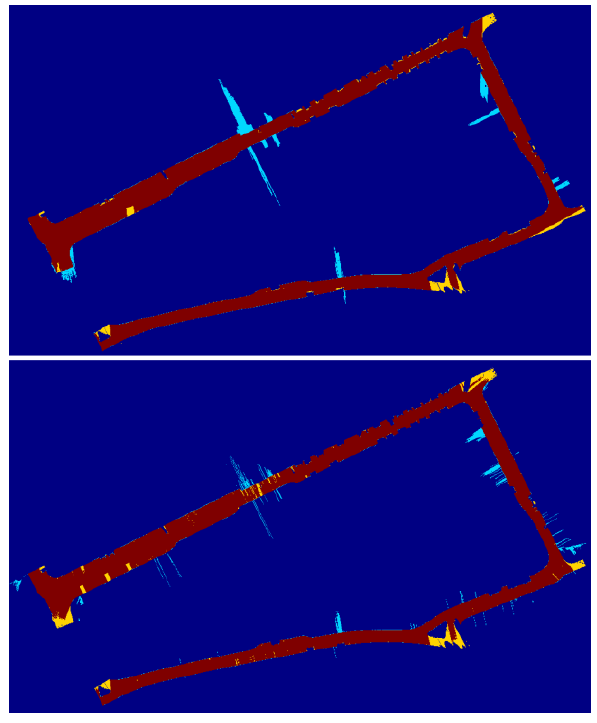
Figure 10. Accuracy assessment of automatic road surface extraction using HDB (top) and HB (down)